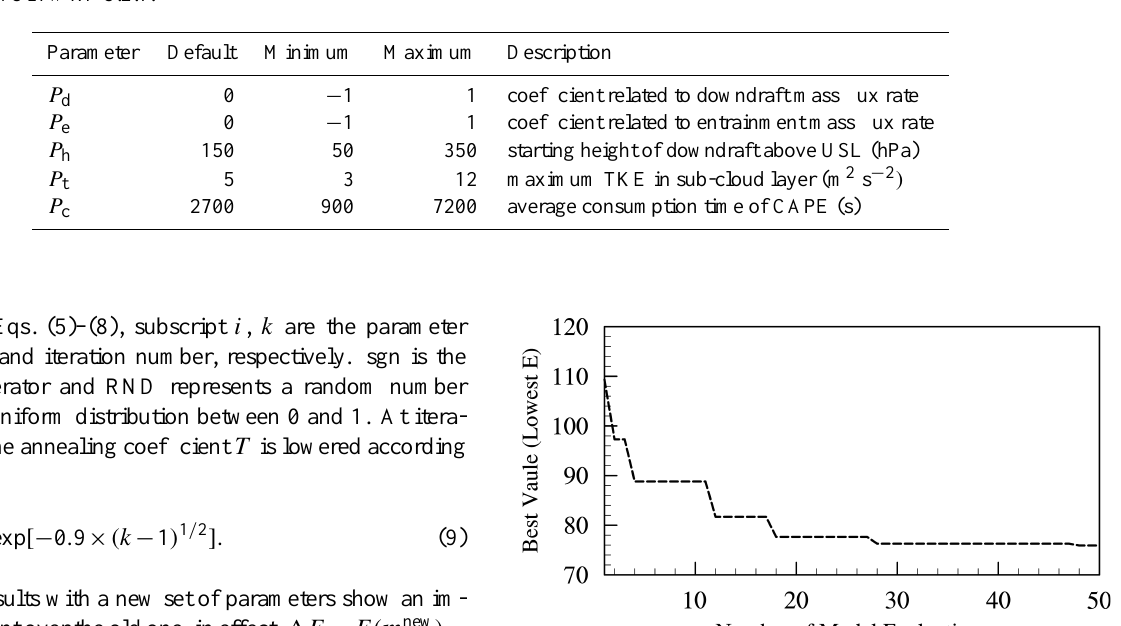
Table 1. The short name, default, minimum and maximum values, and the descriptions of the five parameters in the KF convective parame- terization scheme in WRF 3.2.1.